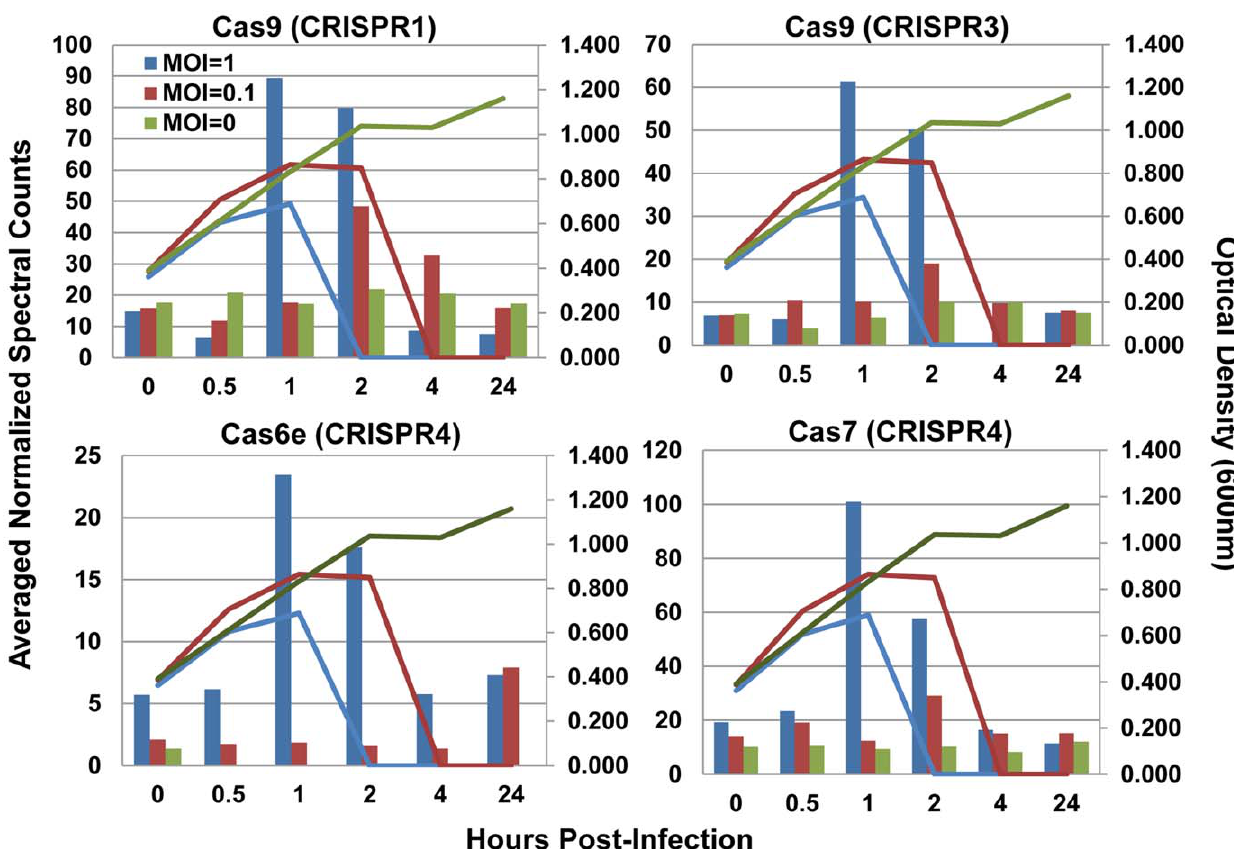
Figure 4. Restriction modification protein subunits increased at peak infection times. Bars indicate normalized spectral counts averaged between two technical replicates and lines are optical density measurements taken at each time point. Untreated cells MOI=0, green bars and lines, infected cells at MOI=0, maroon bars and lines, and infected cells at MOI=1, blue bars and lines. From top left to bottom right: Type I restriction- modification system methyltransferase subunit (ST89_075300), Restriction endonuclease S subunit (ST89_099800) Restriction-modification enzyme type I S subunit; specificity determinant HsdS (ST89_187033), Restriction-modification enzyme type I M subunit; type IC modification subunit HsdM (ST89_187066).